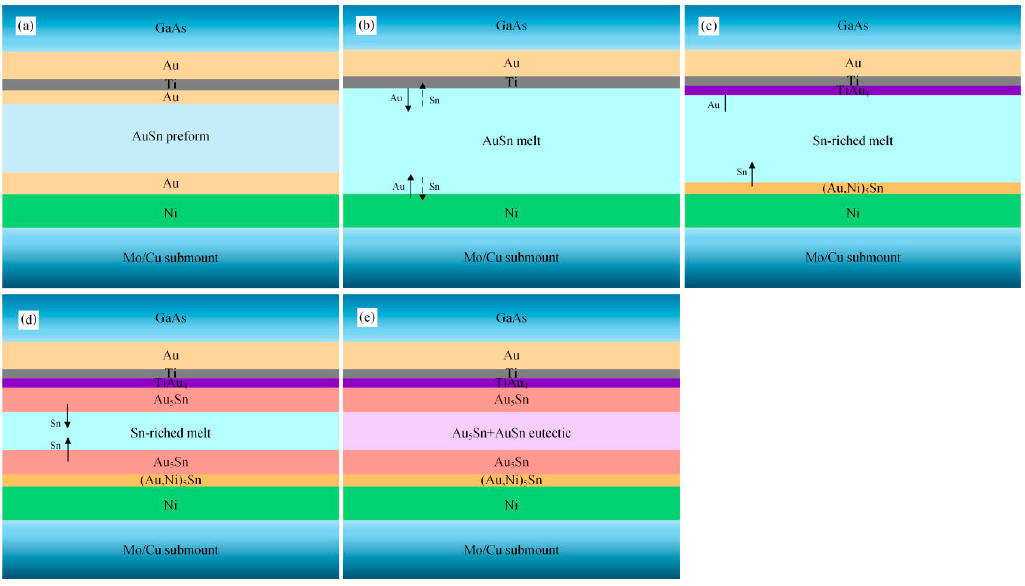
Figure 10. Schematic diagram of the microstructure evolution process of the Au/Ti/Au|Au-Sn joint: ( a ) initial state, ( b ) dissolution and diffusion between the metallization system and the Au-Sn solder, ( c ) formation of TiAu 4 , ( d ) nonisothermal solidification with the formation of Au 5 Sn, and ( e ) nonisothermal solidification with the formation of Au-Sn eutectic.